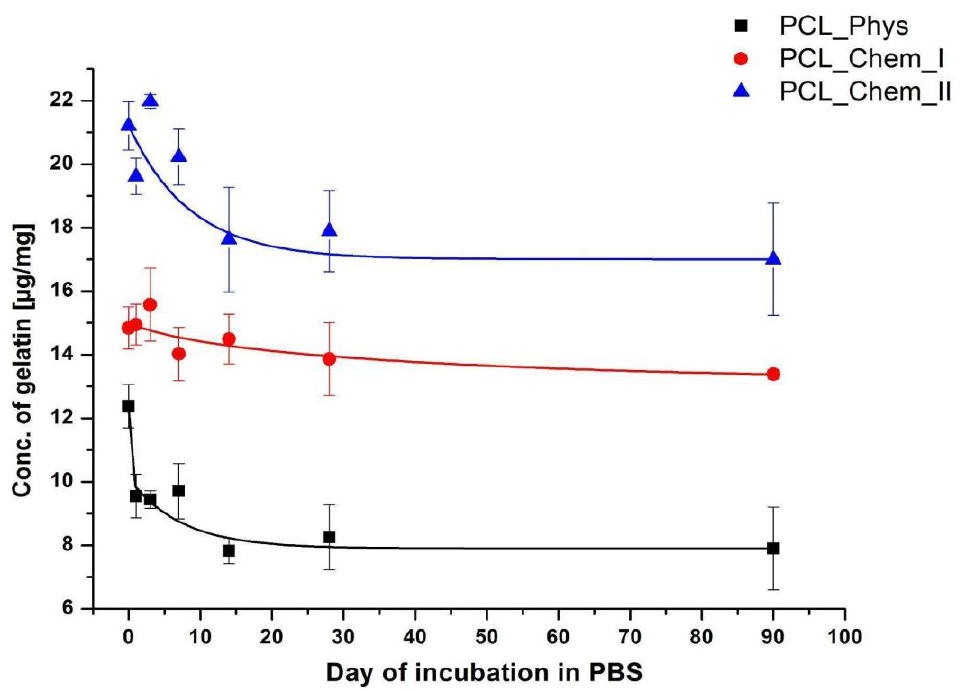
Figure 7. Concentration of gelatin on the PCL fibers as a function of incubation time in PBS for various time points (0; 1; 3; 7; 14; 28; 90 days).